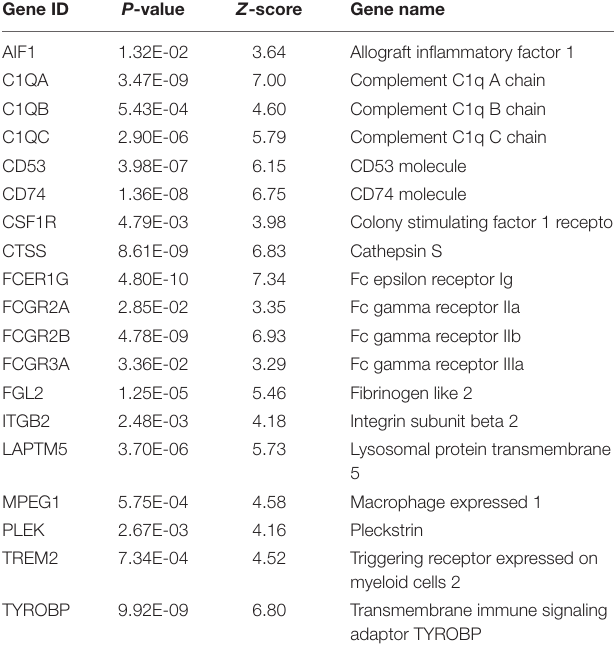
TABLE 1 | Characteristics of the highest-ranked clustering gene module in the protein-protein interaction network of differentially expressed genes of the hippocampus between young (5–8 months) and aged (21–26 months)